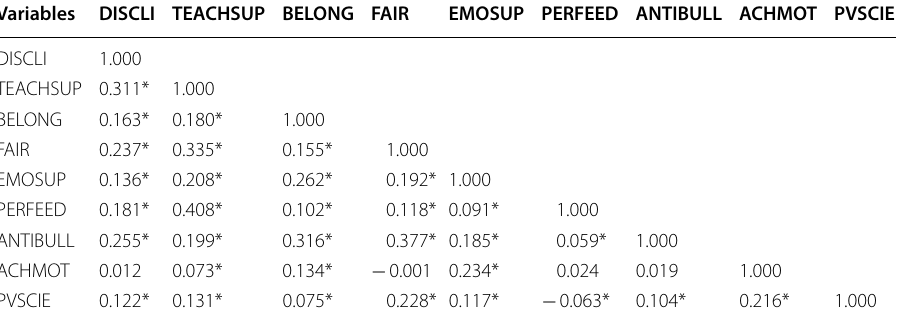
Table 3 Correlations among the profile indicator and outcome variables used in the current